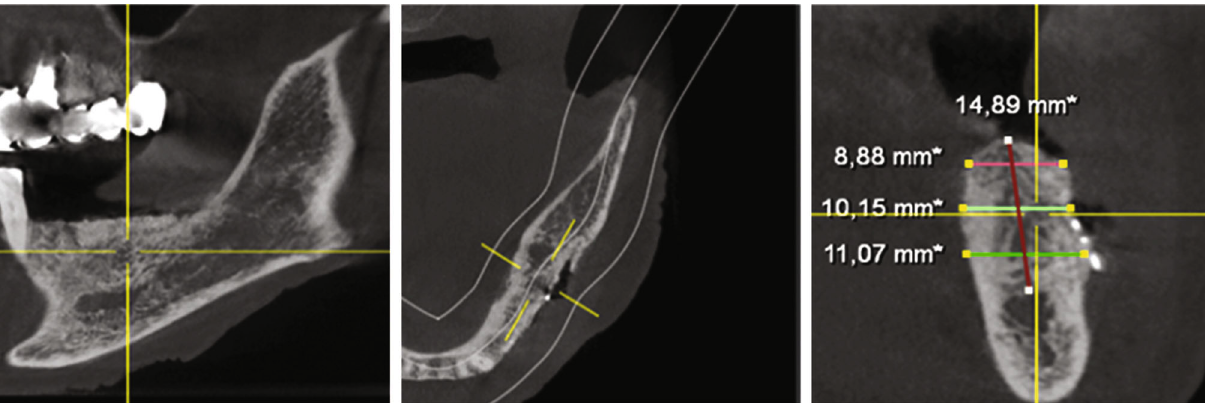
Figure 20: DVT — section; implant position region